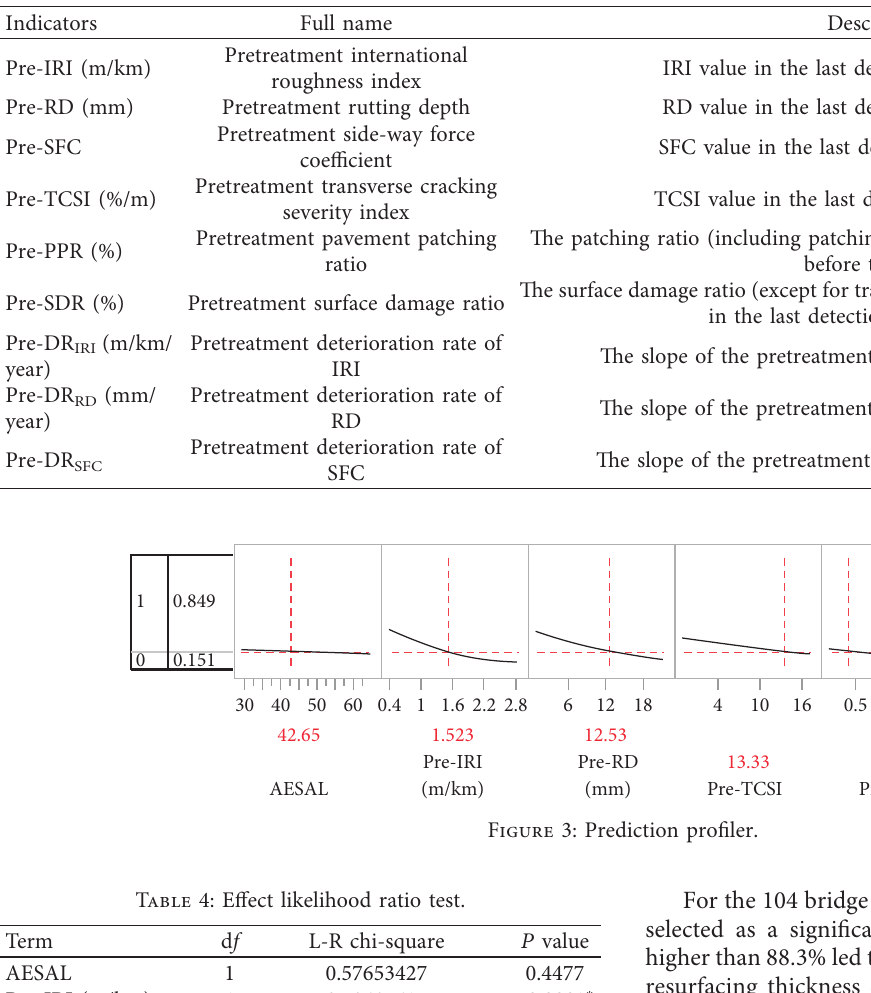
Table 3: The performance